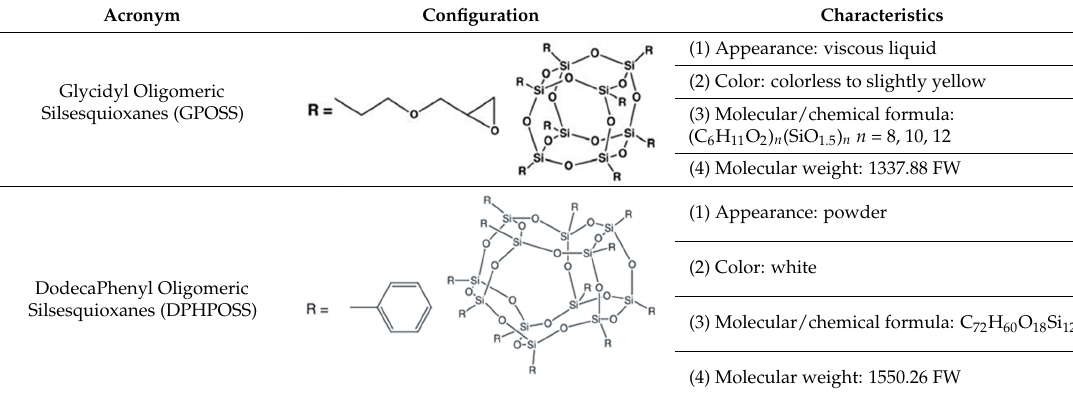
Table 1. Polyhedral Oligomeric Silsesquioxane (POSS) compounds used in this study.